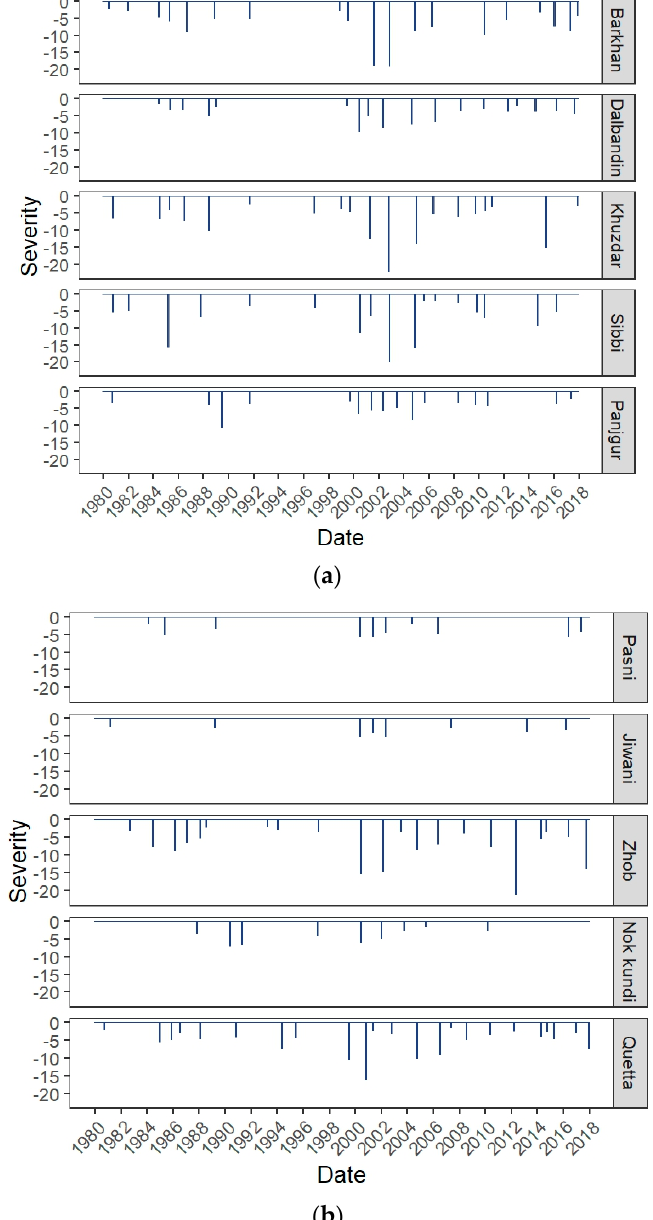
Figure 12. Drought durations at all stations.